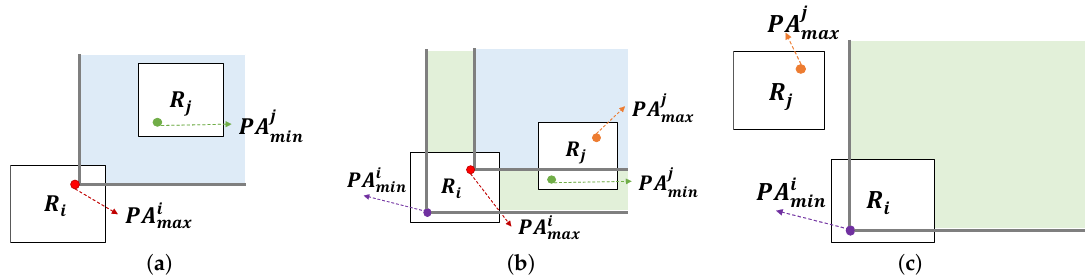
Figure 20. Three cases when refines candidate profitable areas. ( a ) case 1; ( b ) case 2; ( c ) case